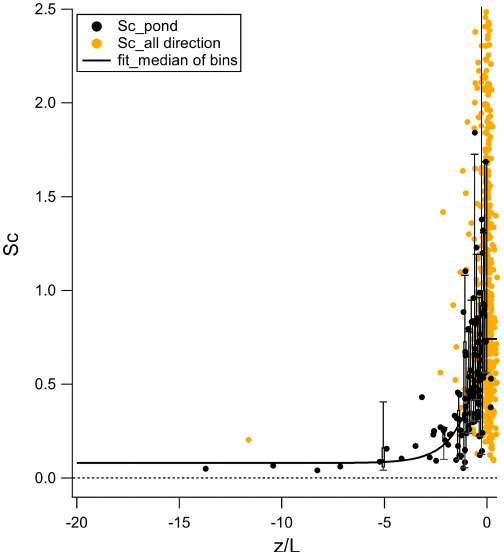
Figure 3. Dependence of Sc on z/L measured at 18m. Yellow points are Sc observed in each individual half-hour period over the entire period; black points are Sc observed in each individual half- hour period when the wind was from the pond; the black curve is the best fit of Sc versus median z/L from each z/L bin when the wind was from the pond. In this analysis, Sc was binned by z/L with 10 points in each bin before